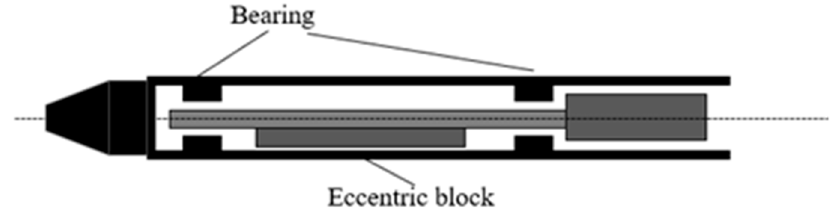
Figure 1. Internal vibration structure diagram of an eccentric vibrator.